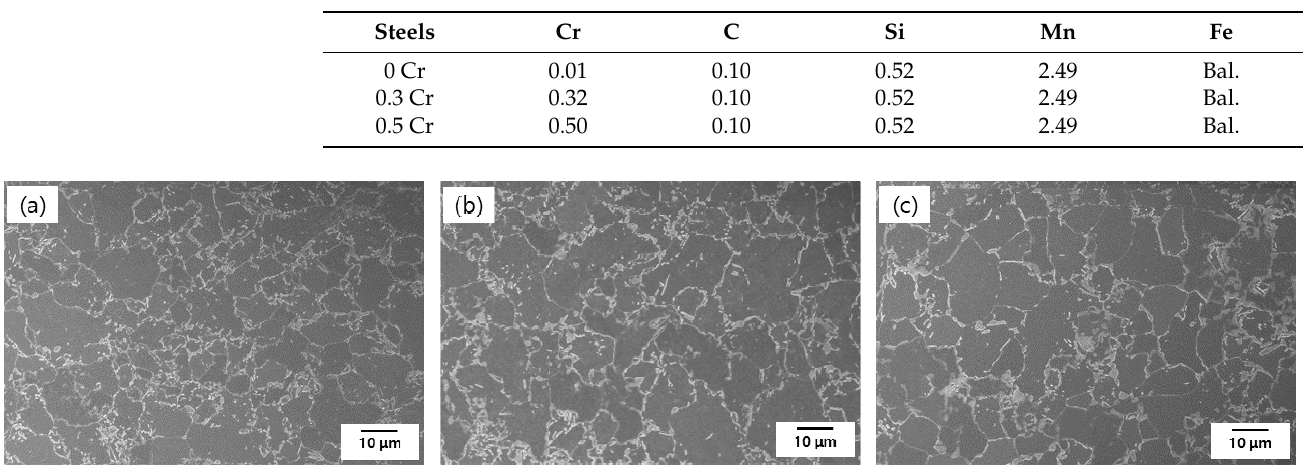
Table 1. Chemical compositions of the specimens (unit: wt.%).